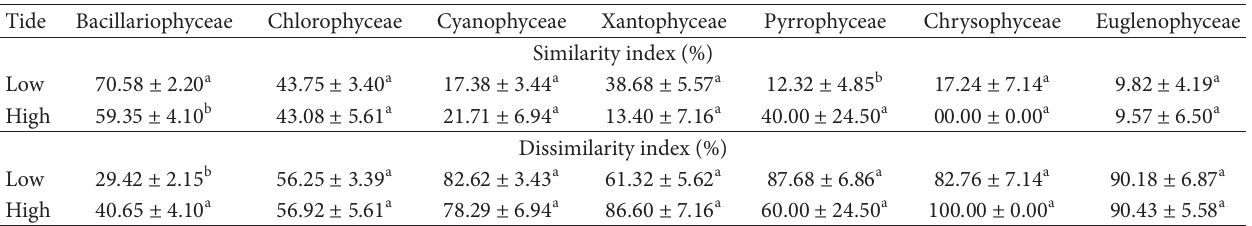
Table 4: Variations of phytoplankton similarity and dissimilarity indices in relation to tide in Okpoka Creek.